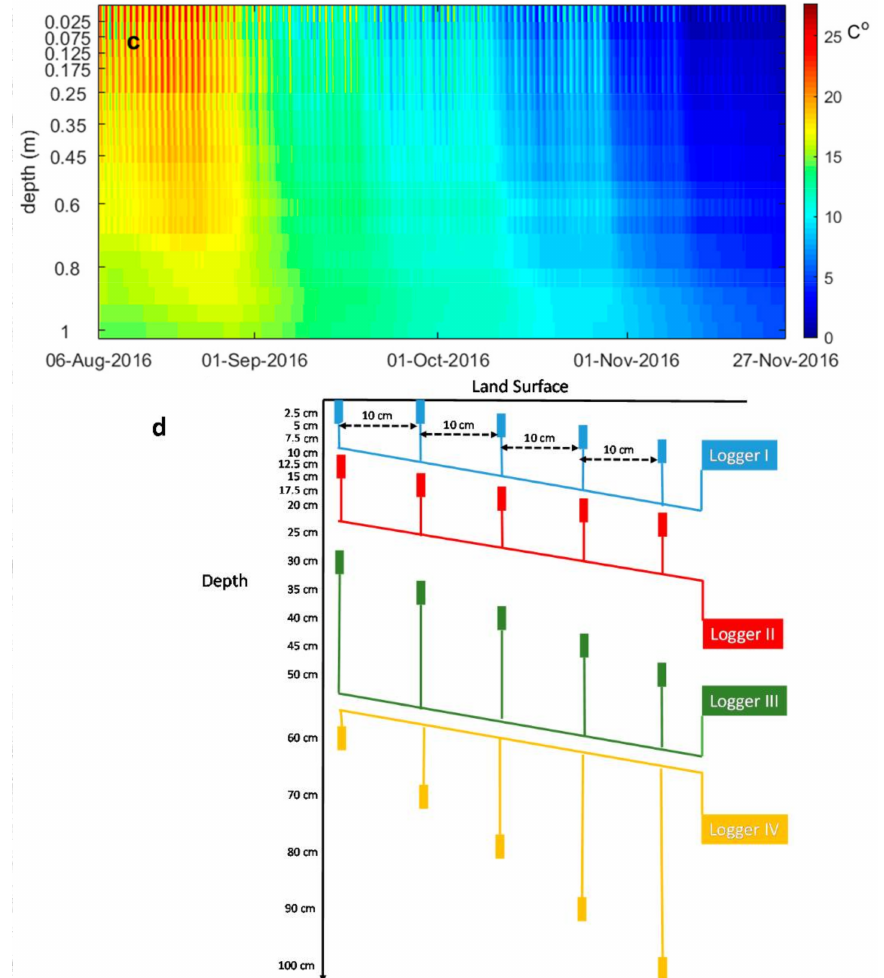
Figure 2. ( a ) precipitation; ( b ) the time series of soil moisture and ( c ) soil temperature profiles at Maqu Network Center Station; ( d ) the installation configuration of 20